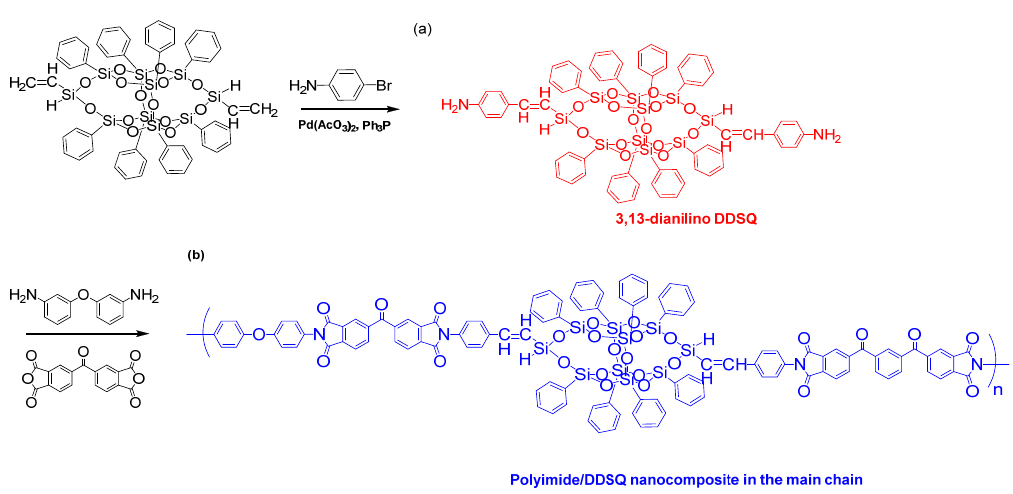
Figure 11. TEM m icrographs of the synthesis of PIs containing various contents of 5,11,14,17 Figure 11. TEM micrographs of the synthesis of PIs containing various contents of 5,11,14,17 tetranilino tetranilino DDSQ [81]. Reproduced with permission from Wiley. DDSQ [81]. Reproduced with permission from Wiley. Polymers 2019 , 11 FOR PEER REVIEW